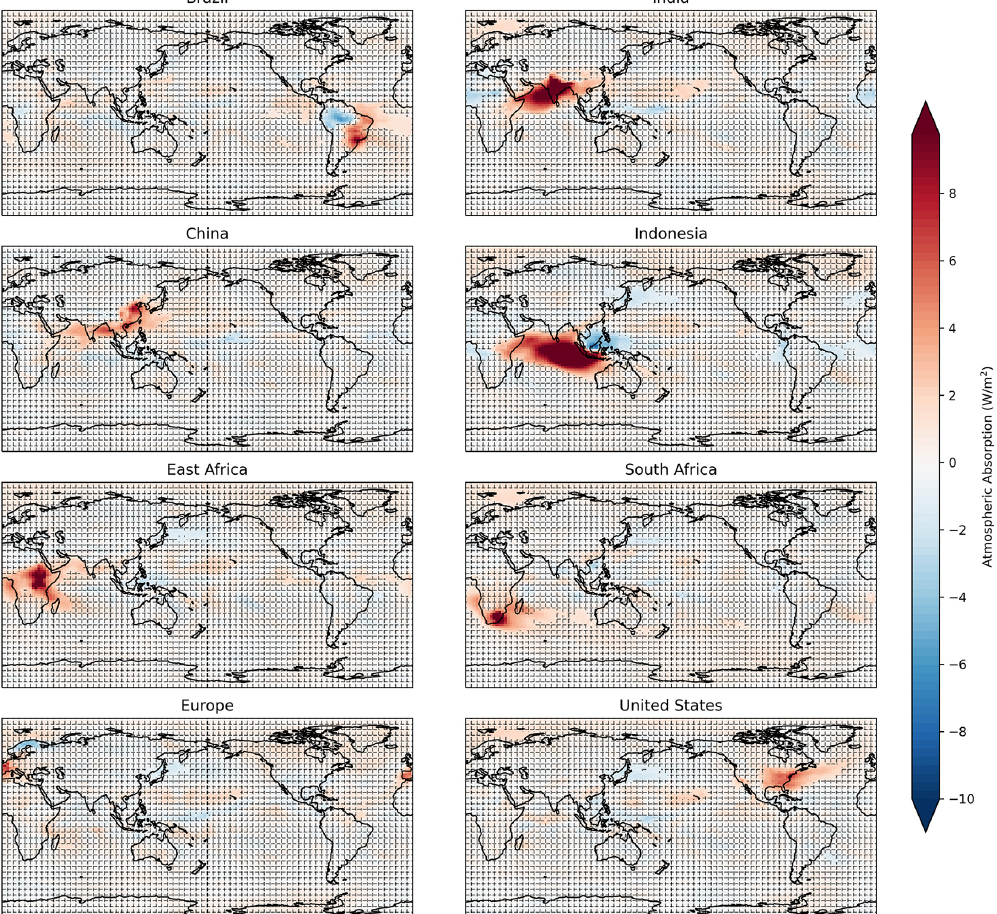
Figure 6. Spatial distribution of the change in atmospheric absorption (Wm − 2 ) due to the addition of an identical aerosol emissions amount and composition in each of the eight regions. Grid lines indicate regions where the changes are not statistically significant at the 95% confidence level via a two-sided t